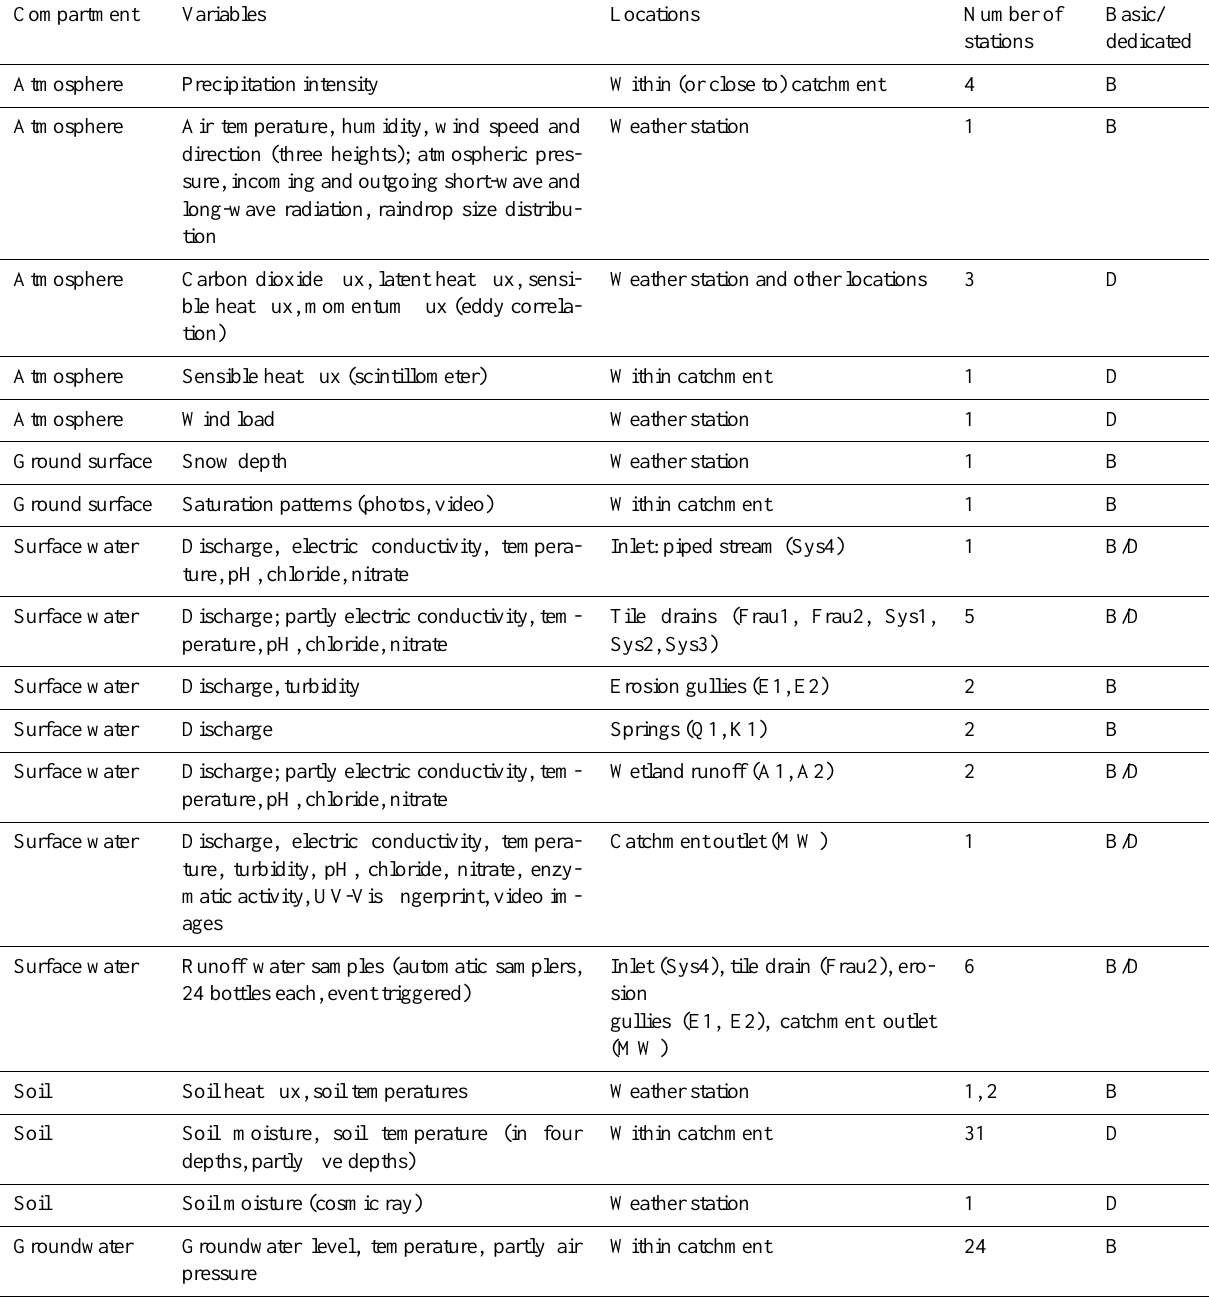
Table 1. Instrumentation in the HOAL (most of which has a 1min time resolution). Most data are transmitted to the server at the institute by glassfibre cable. For details, see Appendix B; for locations, see Figs. 6 and 7.